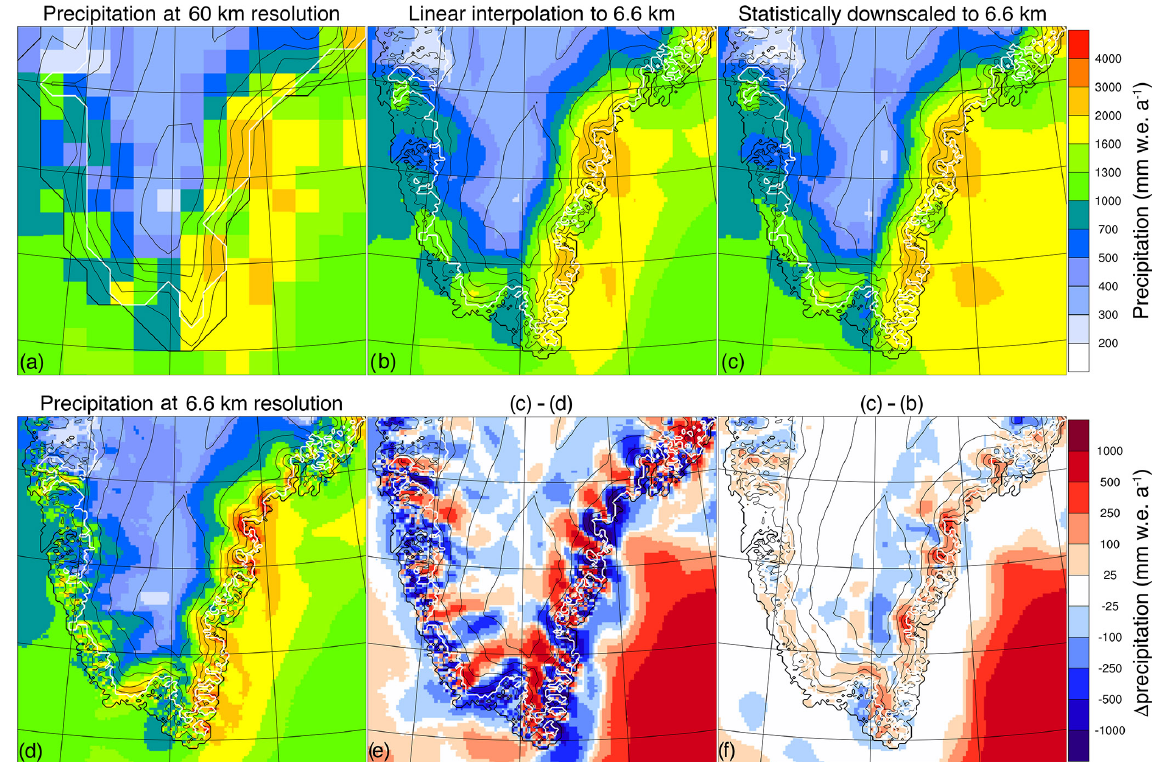
Figure 3. Results from refining precipitation from 60km resolution to 6.6km resolution. (a) Modelled precipitation at 60km resolution. (b) Bilinear interpolated precipitation. (c) Statistically downscaled precipitation using local regression to elevation. (d) Modelled precipitation at 6.6km resolution. (e) Difference between statistically downscaled (c) and modelled (d) precipitation. (f) Difference between statistically downscaled (c) and bilinear interpolated (b) precipitation. The white line marks the ice sheet margin.